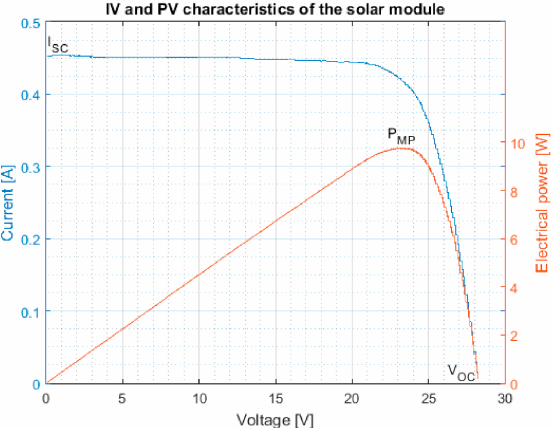
Figure 5. Typical IV and PV characteristics of a solar